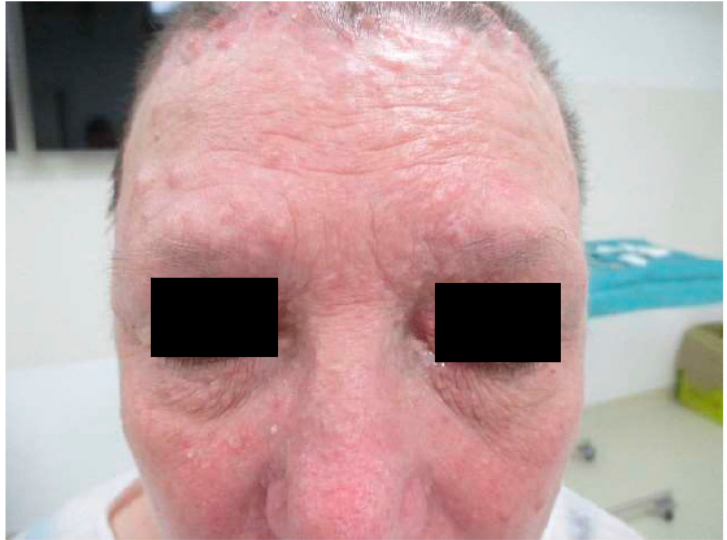
Figure 9. Multiple facial trichoepitheliomas.